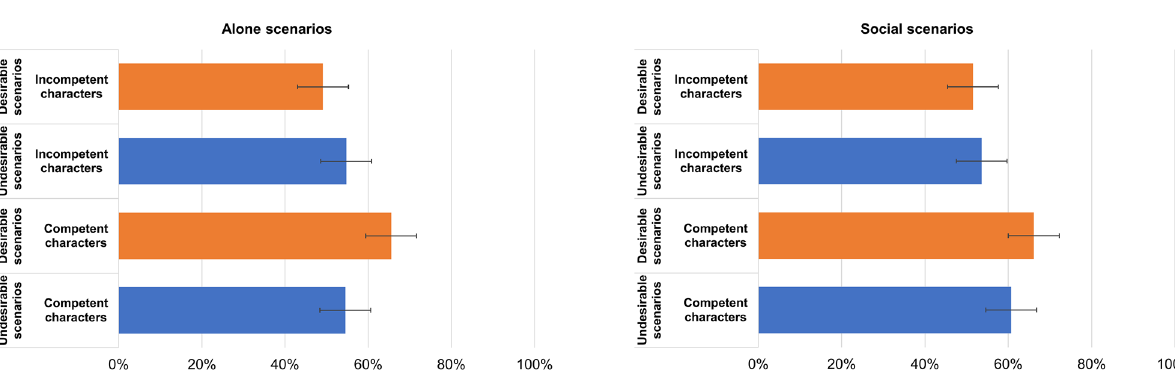
Figure 2. Interaction effects between competence, valence and sociality. The bars represent 95% confidence